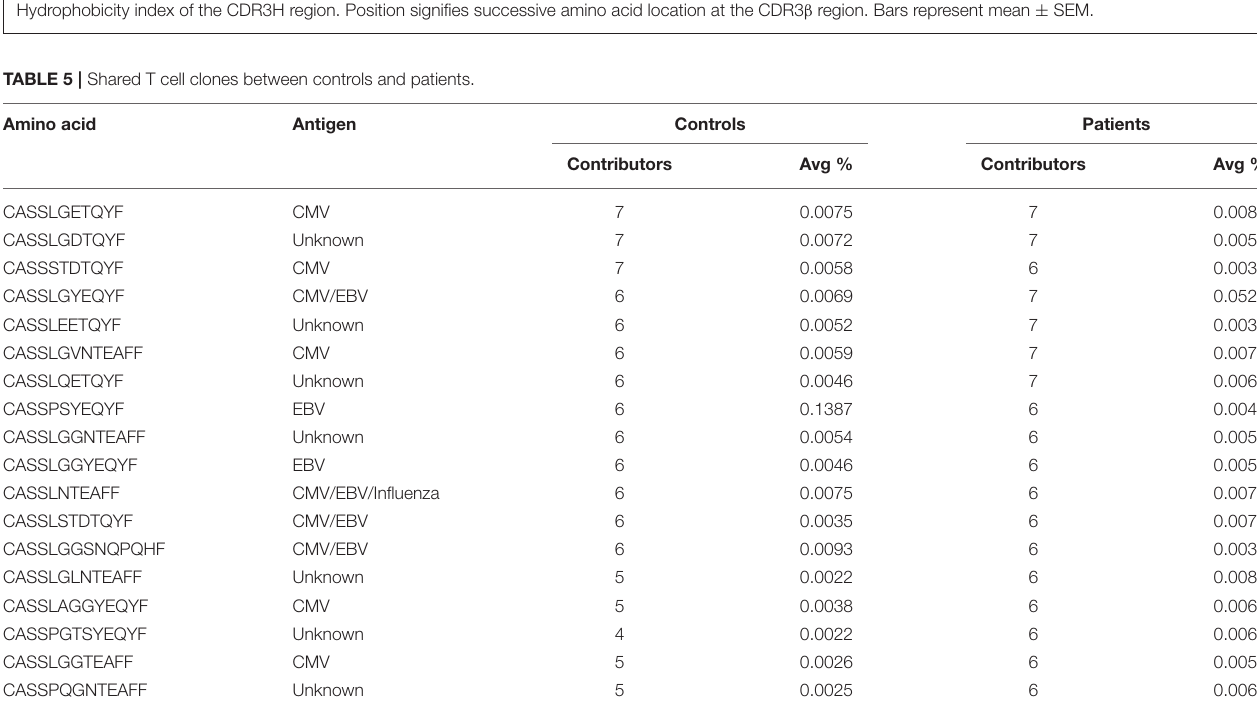
Table displaying clones that are shared between at least 6 controls or 6 patients. CMV, Cytomegalovirus; EBV, Epstein–Barr